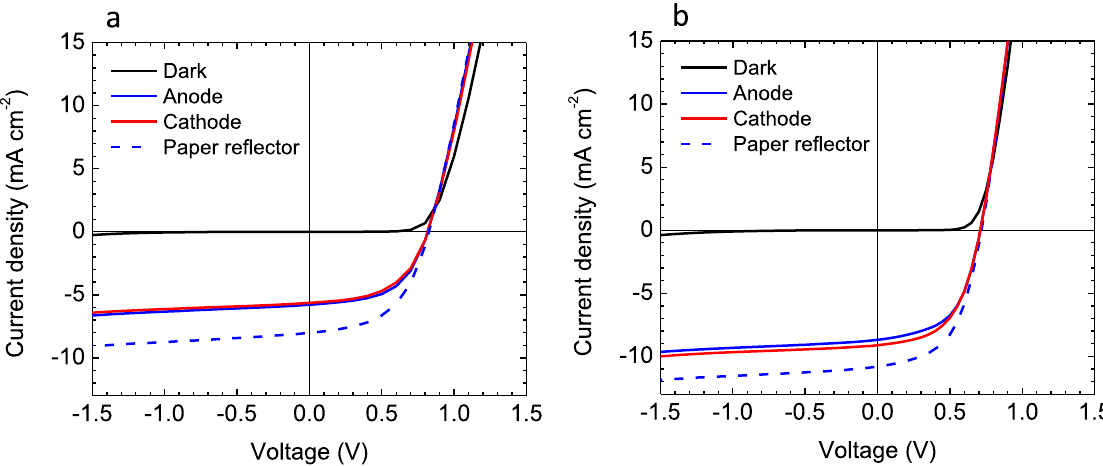
Fig. 7 BHJ/PCBM lamination JV-curves of a TQ1:PC 71 BM and b PI4 laminated A1/A2 BHJ/PCBM semitransparent solar cells illuminated through the anode (solid blue), cathode (solid red) and with the addition of a white paper re fl ector (dashed blue, illumination from the anode side)